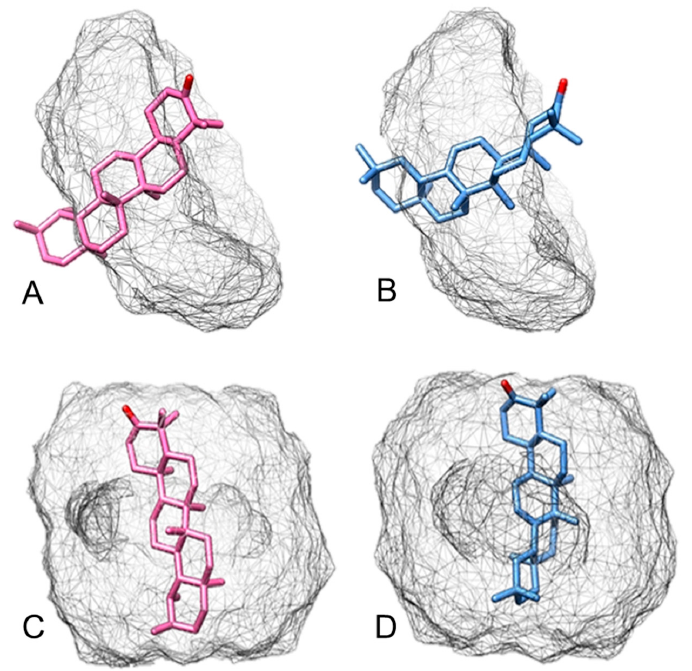
Figure 4. Energetic simulation of the interaction between α , β -amyrenone and β -cyclodextrin ( γ CD) in the molar ratios of 1:1 ( A , B ) and 2:1 ( C , D ). ( A ) α -amyrenone: γ CD, coupling with the face containing hydroxyl groups inside the γ CD cavity, ( B ) β -amyrenone: γ CD, coupling with the face containing the hydroxyl groups outside the γ CD cavity, ( C ) α -amyrenone: γ CD in complete coupling, ( D ) β -amyrenone: γ CD, in complete coupling.